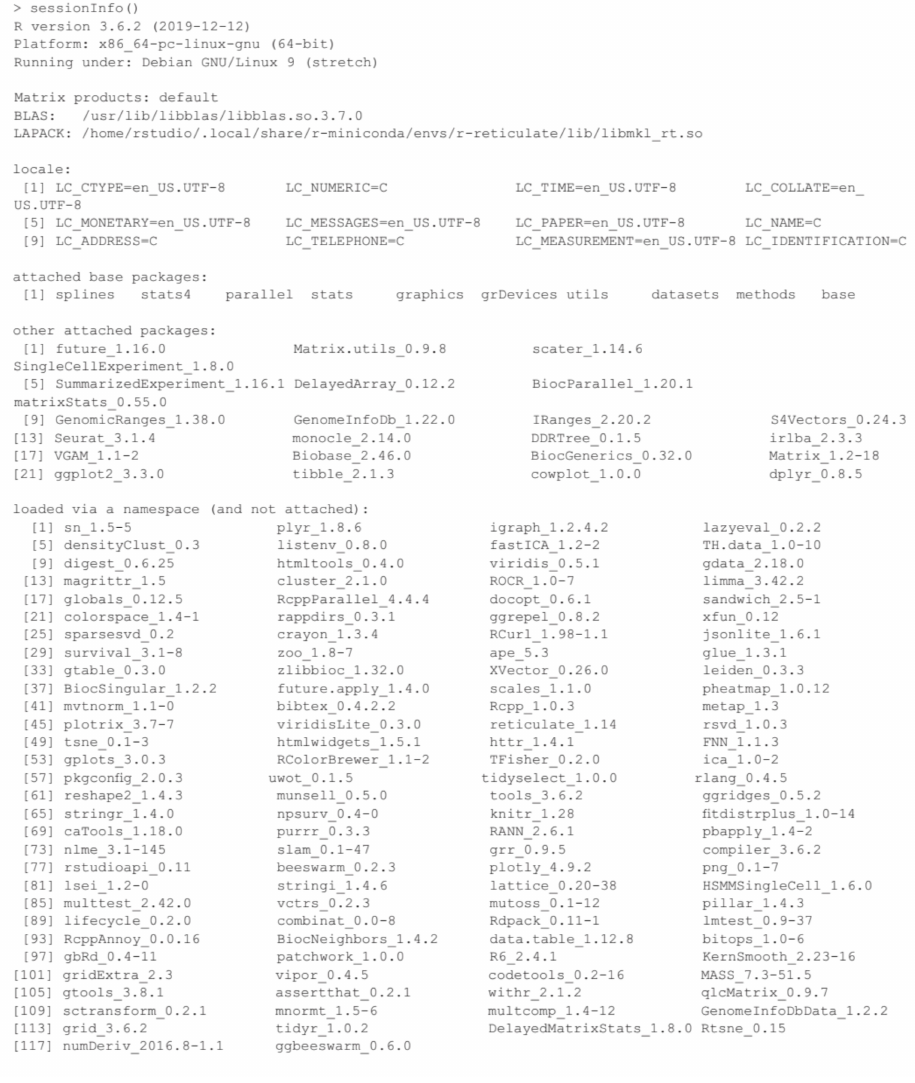
Figure A14. Details of R session and loaded